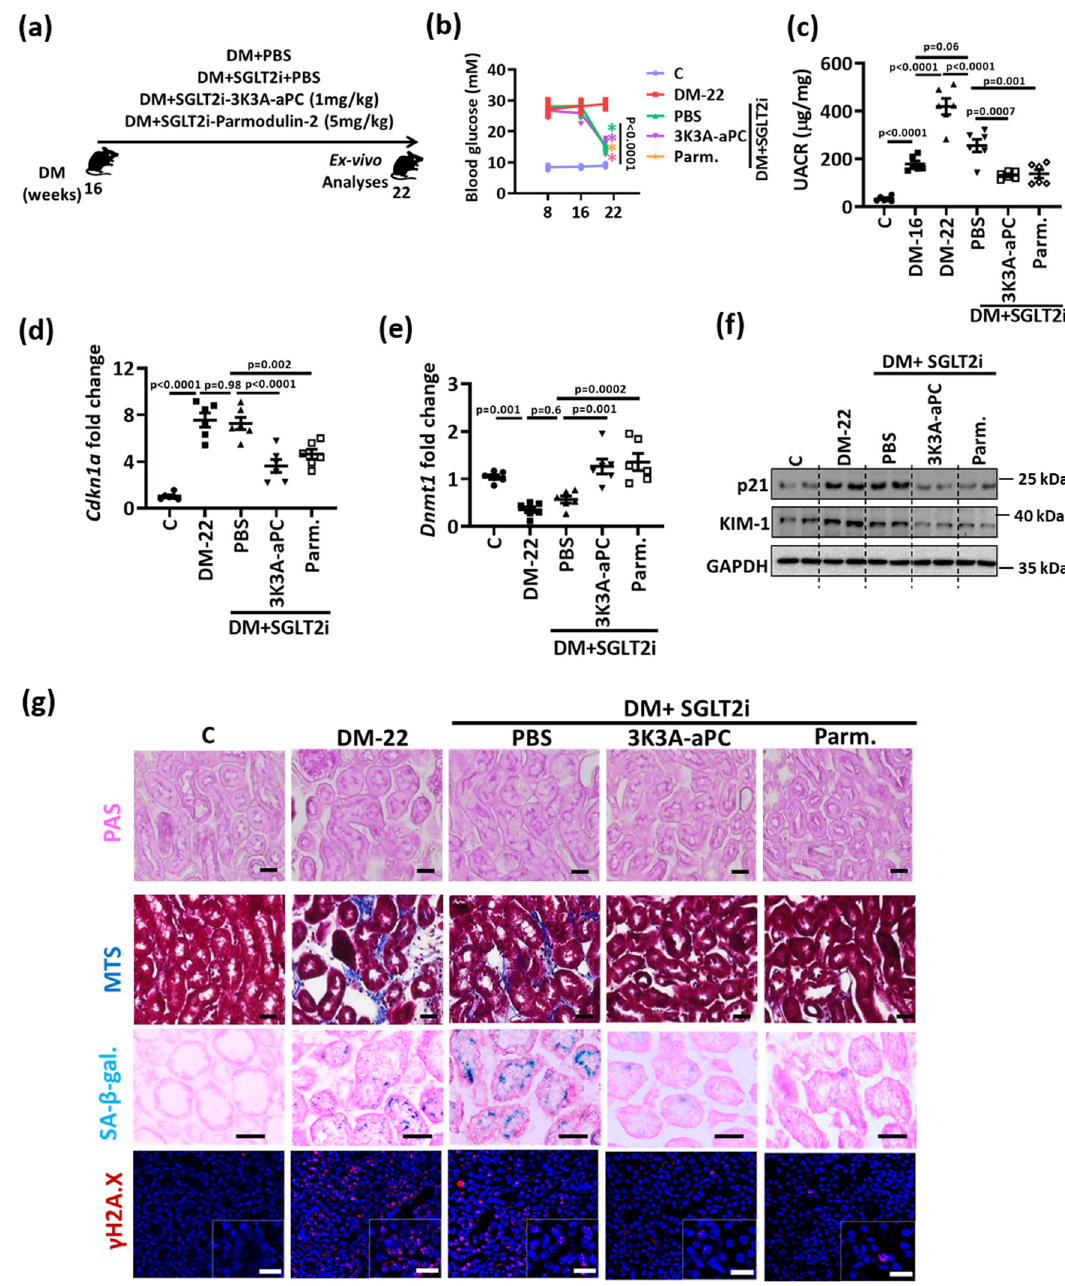
Fig. 8 | aPC regulates epigenetically sustained p21 expression independent of its anticoagulant function. a Experimental scheme: 16 weeks after induction of persistenthyperglycemia,diabeticmiceweretreatedwithPBS(DM+PBS),sodium/ glucose cotransporter 2-inhibitor (Dapagli fl ozin ® , DM+SGLT2i), a combination of SGLT2i and 3K3A-aPC (DM+SGLT2i+3K3A-aPC) or a combination of SGLT2i, aPC and parmodulin-2 (DM+SGLT2i+Parm.) for further 6 weeks. b Average blood glucoselevelsafter8andand16weeksofpersistenthyperglycemiaandat22weeks in experimental groups (as described in a ). c Dot plot summarizing albuminuria (urinary albumin-creatinine ratio, µ g albumin/mg creatinine; UACR) in experi- mental groups (as described in a ). Baseline albuminuria before interventions was determined after 16 weeks of hyperglycemia (DM-16). d – f Expression of renal p21